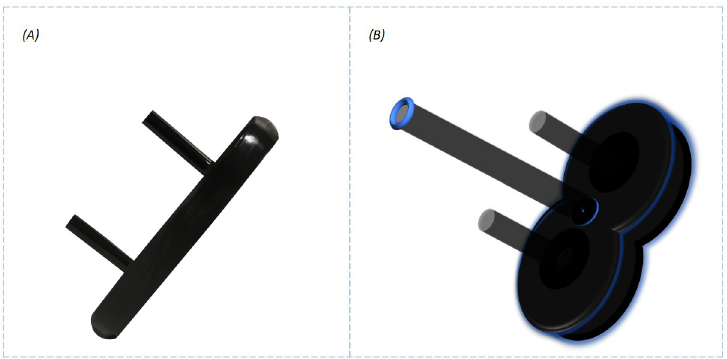
Fig 5. TMS prop. (A) Side view of the plastic prop used to suppress phosphene perception. The props thickness measured 20mm and was wrapped in vinyl tape which was the original encasing of the 40mm figure-of-eight coils. Stemming from the base are two plastic cylinder-shaped bars that were designed to fit tightly within the holes of the coil. (B) Illustration showing the prop mounted onto the coil. The prop was designed to reflect the coils dimensions as seen from this